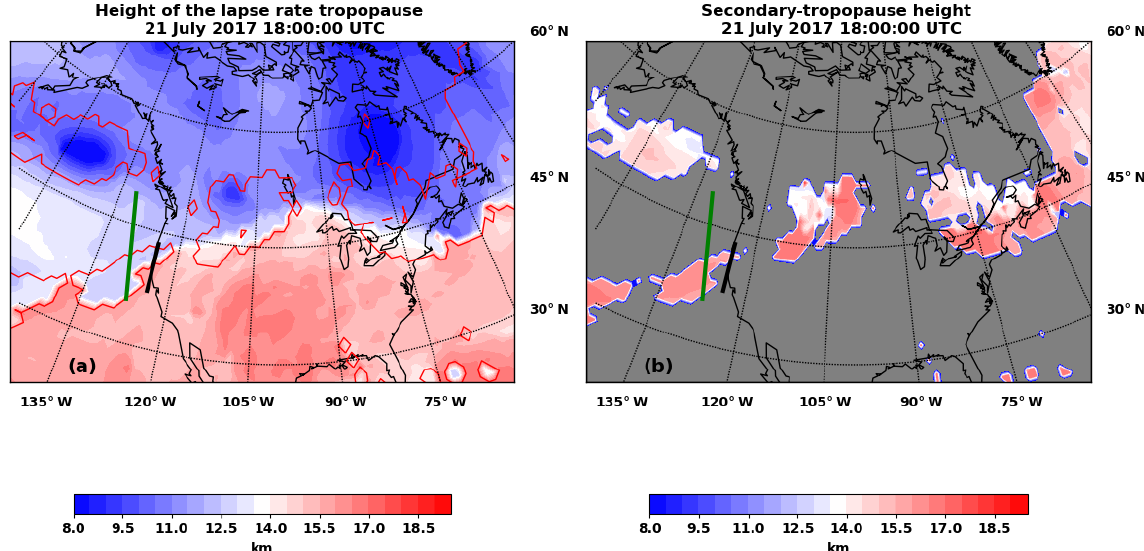
Figure 4. Height of the thermal tropopause (a) and the height of the secondary tropopause (b) for the 18:00UTC time step. The red outline in (a) denotes the edge of the double-tropopause regions shown in (b) . The measurement tracks of SHOW and MLS are shown in black and green respectively.